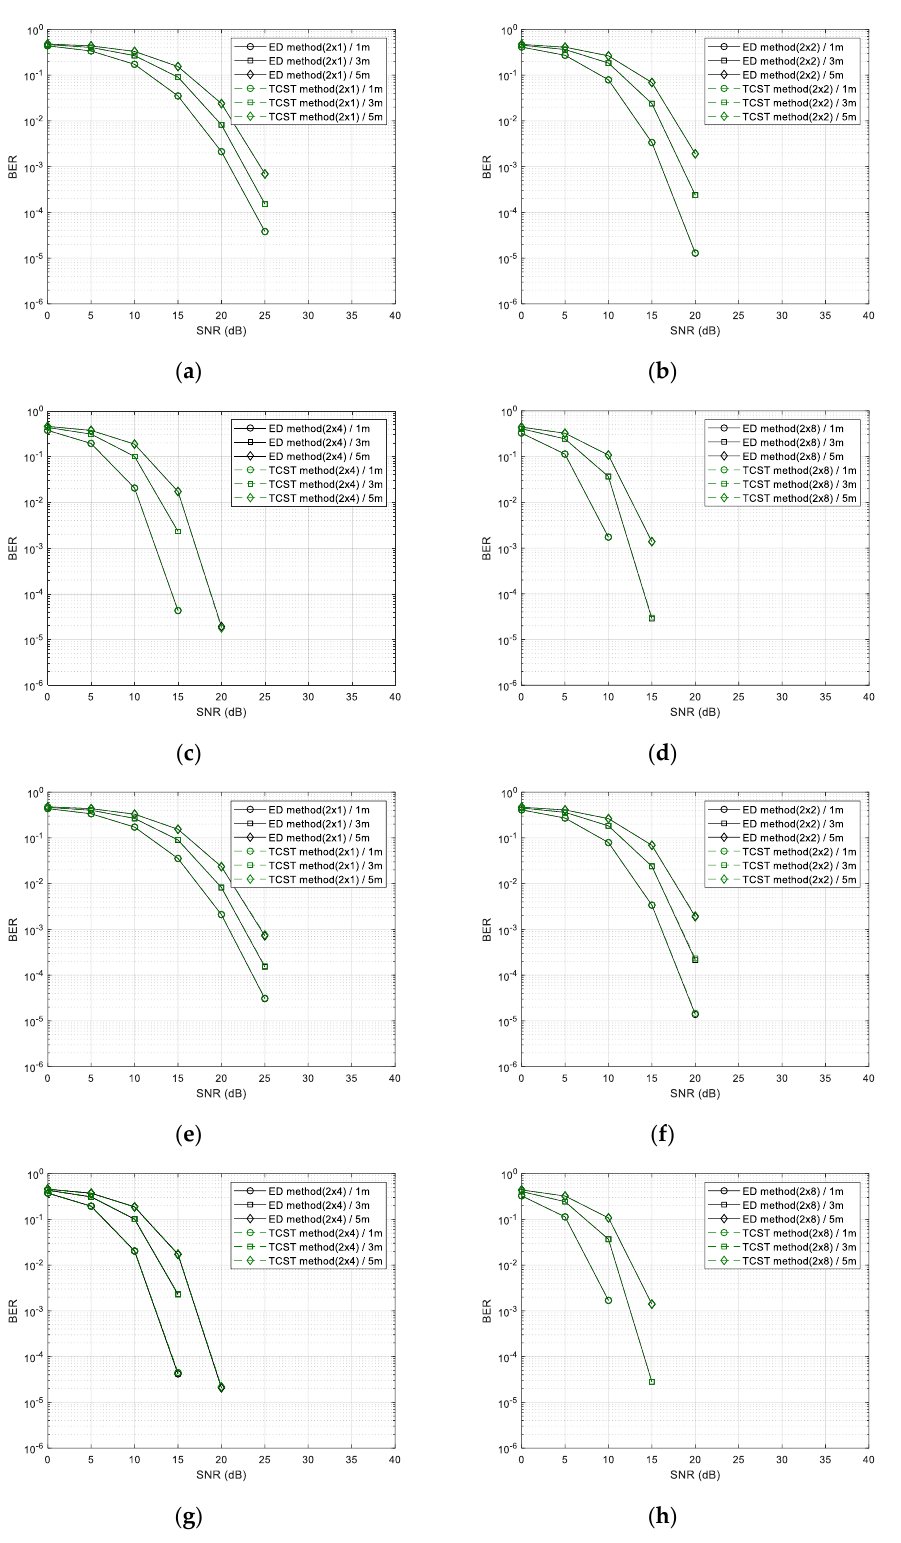
Figure 10. BER performance of TCST method for the number of received (Rx) antennas (1, 2, 4, and 8). From ( a ) to ( d ) when adopting the optimal threshold values with increasing the number of Rx antennas from 1 to 8; from ( e ) to ( h ) when adopting threshold values calculated from the estimated RSSI (received signal strength indicator) with increasing the number of Rx antennas from 1 to 8.